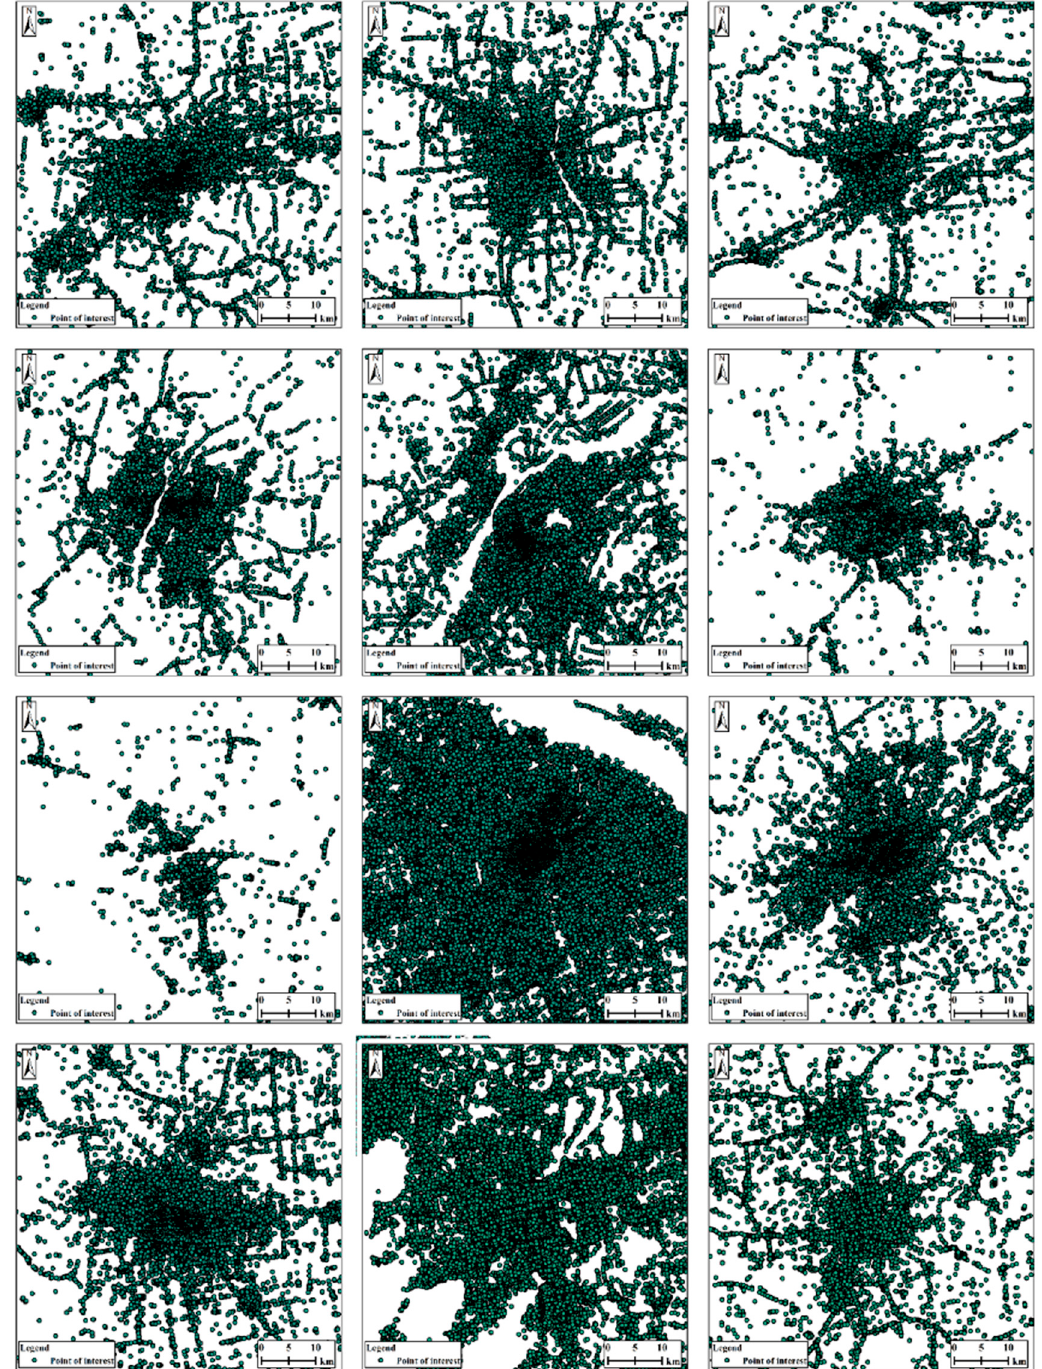
Figure A4. Figure A4. Map of the point of interest (POI) data for the 32 Chinese cities.